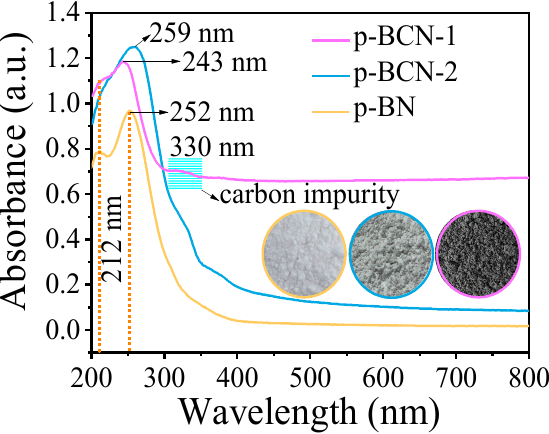
Figure 10. UV–vis diffuse reflectance spectra of p-BN, p-BCN-1, and p-BCN-2 samples.